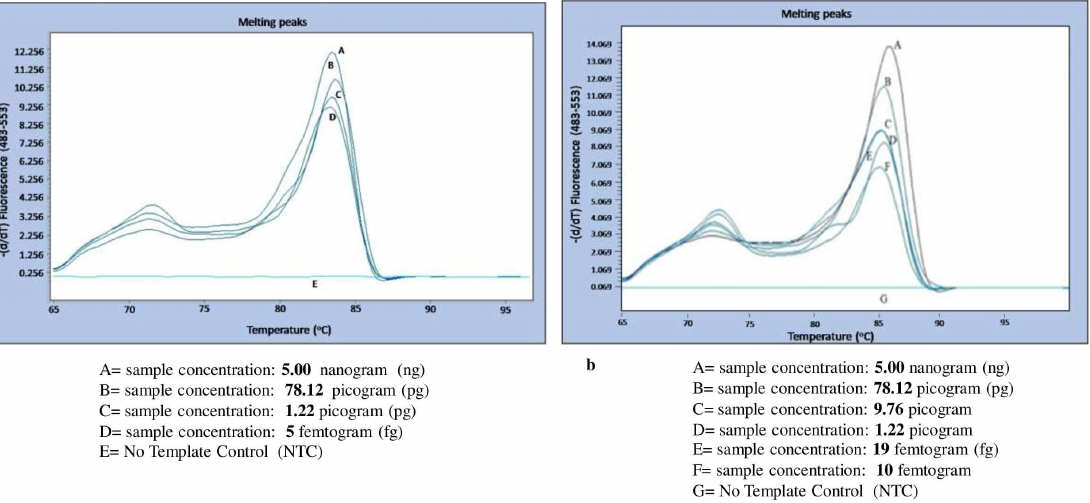
Figure 5. ( a , b ): Melting curve showing the detection limit for P. falciparum and P. vivax with respect to constant primer concentration (250 ng) and different sample concentrations. The graph was generated by using Light Cycler 480 software (version 4., Light Cycler 480, Roche Rotkreuz, Switzerland).